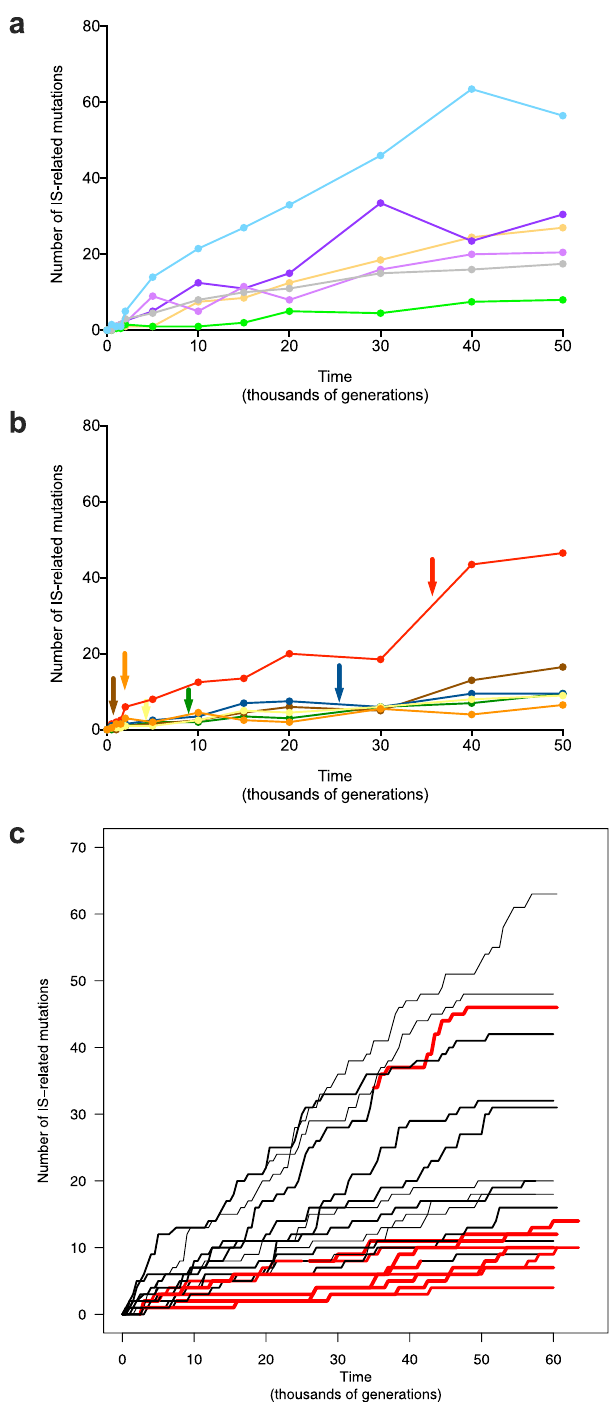
Fig. 3 Dynamics of IS-related mutations in the LTEE populations.